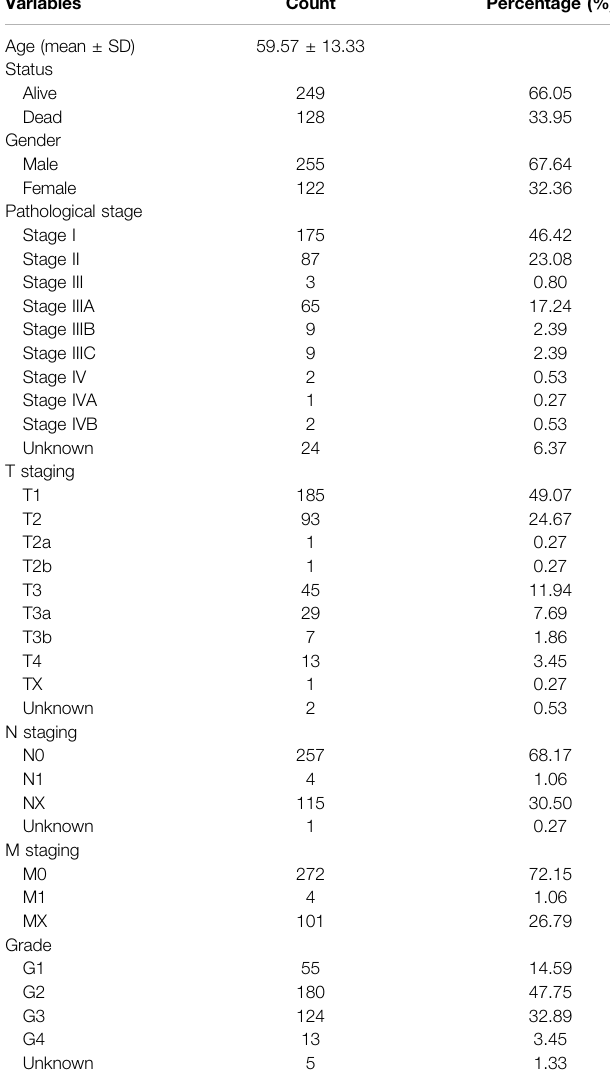
TABLE 1 | Clinicopathological features of